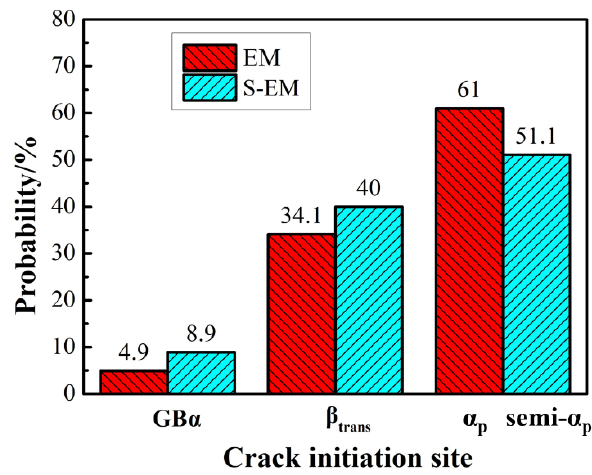
Figure 15. The crack nucleation probability at different sites of the EM and S-EM.